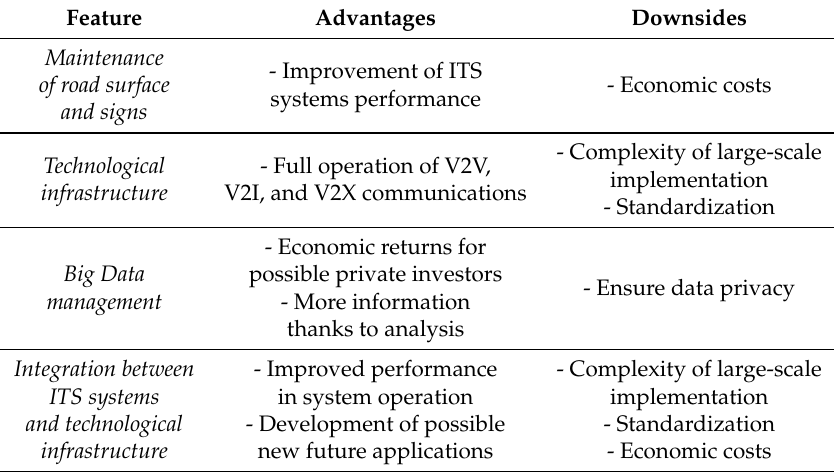
Table 2. Purposes and downsides of future vehicular